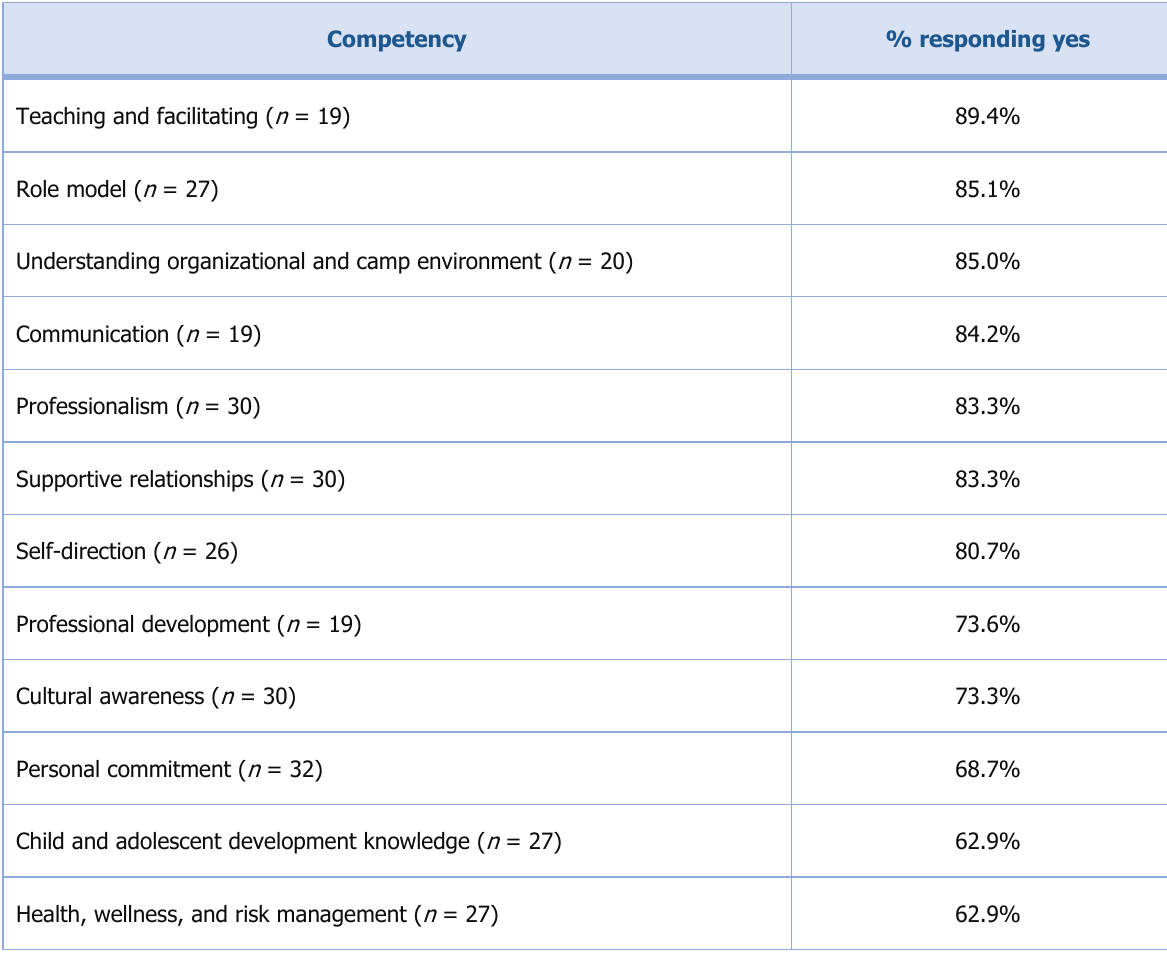
Table 7. Counselors’ Belief About Whether Skills from Competency Sessions Were Used During the Camping